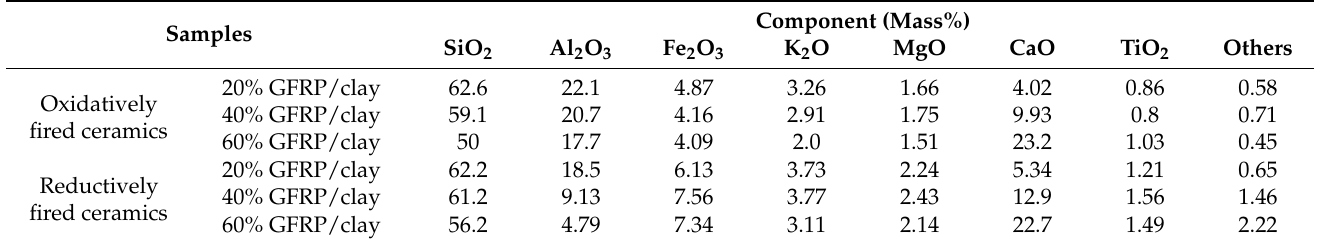
Table 2. Inorganic chemical compositions of the GFRP/clay ceramic